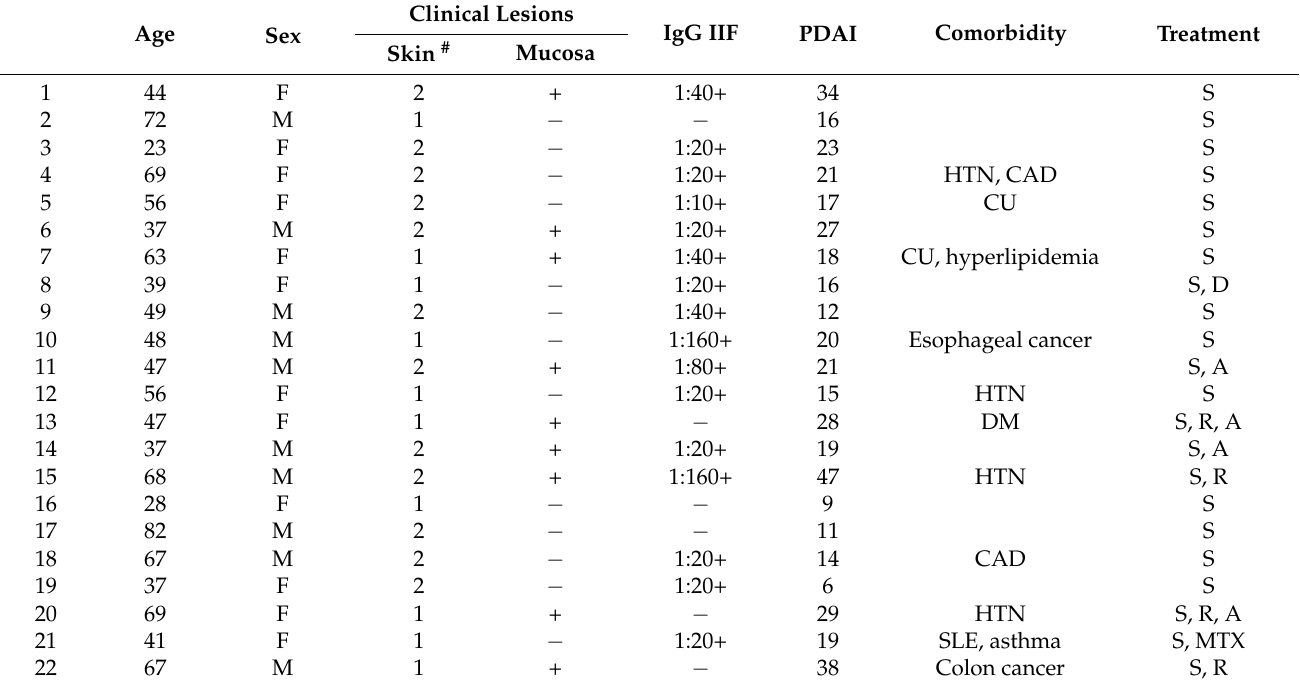
Table 1. Demographics and clinical presentation of patients with IgG/IgA